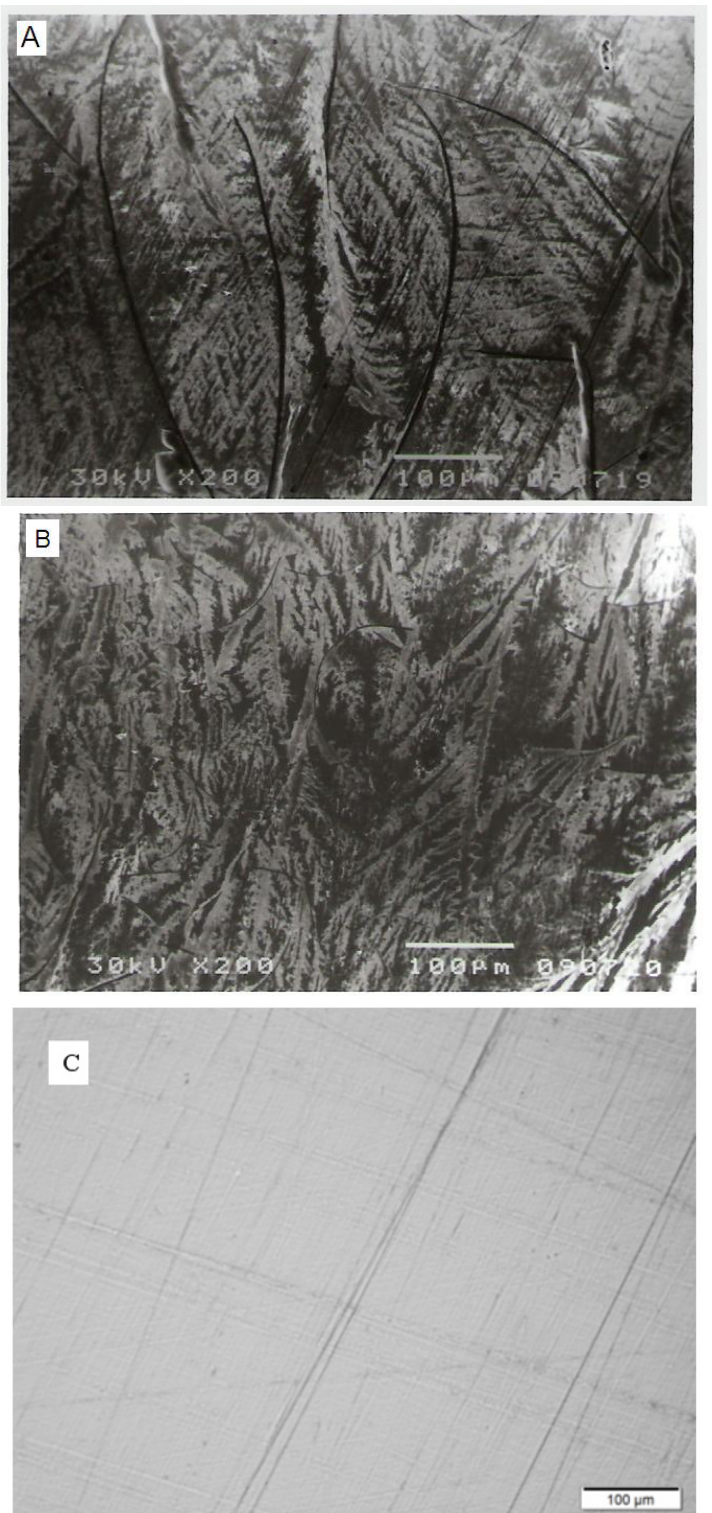
Figure 8. Scanning electron microscopic (SEM) examination of the 4-ABA films on stainless steel obtained during their electrodeposition by cyclic voltammetry (A) and galvanostatically (B) and . bare stainless steel (C) Magnification applied,